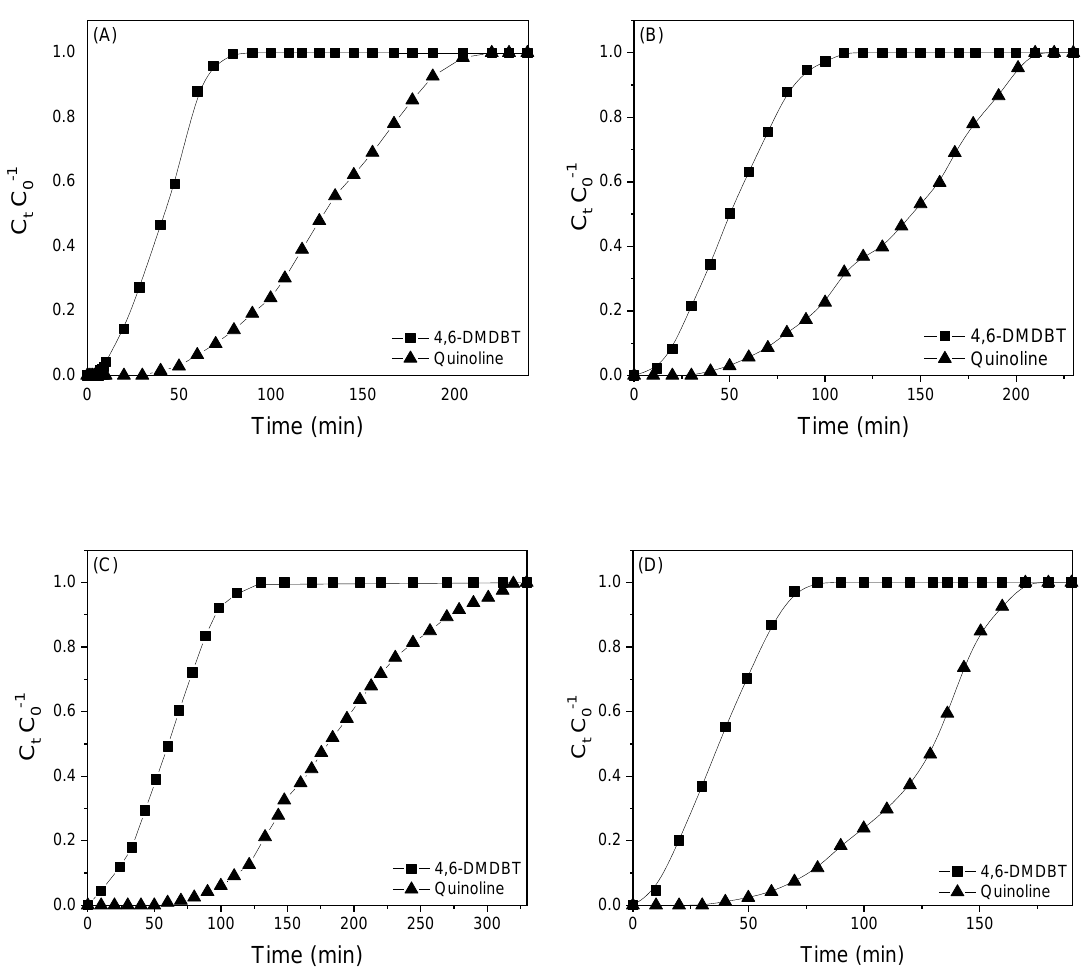
Figure 2. Adsorption curves for 4,6-DMDBT (squares) and QN (dots) for: ( A ) γ-Al 2 O 3 ; ( B ) B(0.4) γ-Al 2 O 3 ; ( C ) Ni(4.0) γ-Al 2 O 3 and ( D ) Ni(4.0) B(0.4) γ-Al 2 O 3 .